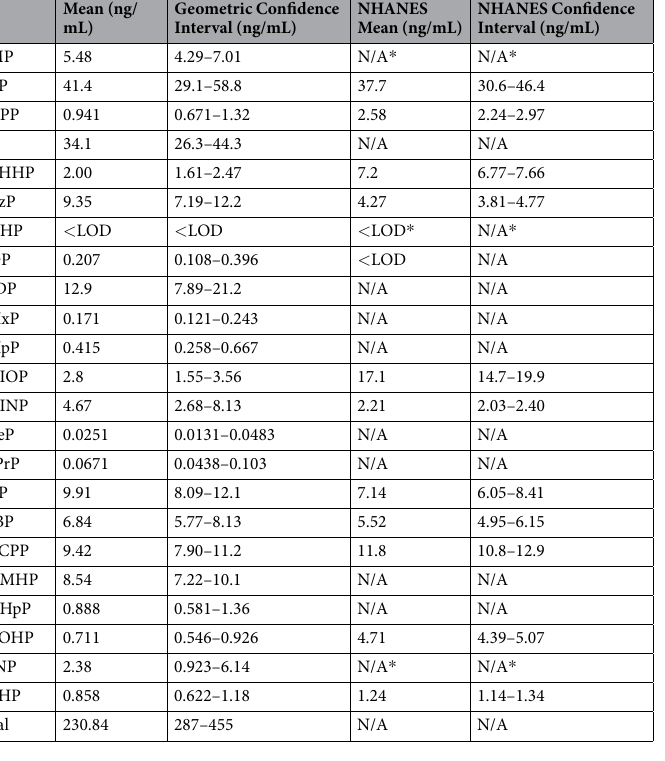
Table 2. Summary of phthalate data for all 23 metabolites measured. * Data not determined for 2011–2012. Data presented is from 1999–2010. All data reported as mean is geometric mean with corresponding geometric 95% confidence interval. Abbreviations: limit of detection (LOD), mono-(2-ethyl-5-carboxypentyl)